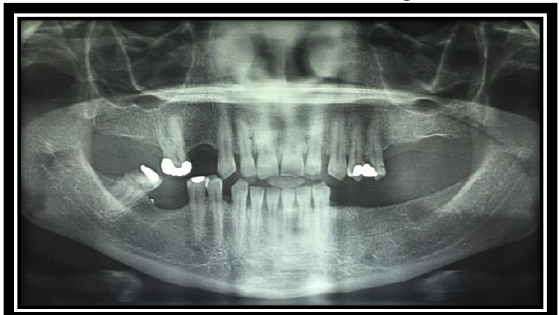
Figure1:Diagnostic preoperative panoramic radiograph (OPG).